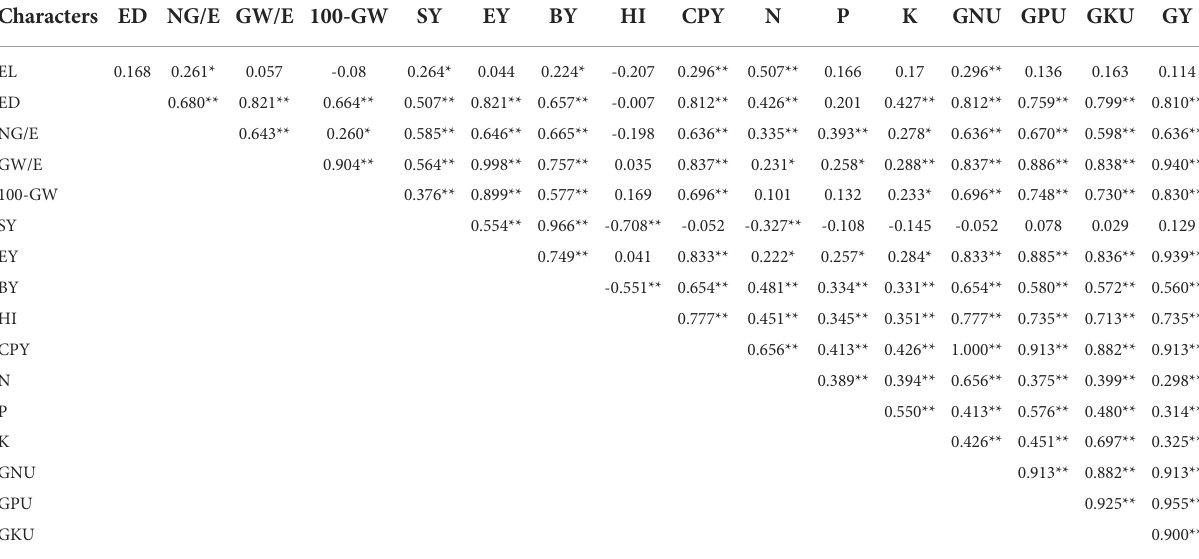
TABLE 5 Correlations (Pearson correlation coef fi cient) between the study traits in maize as calculated from the combined data across two years. Characters ED NG/E GW/E 100-GW